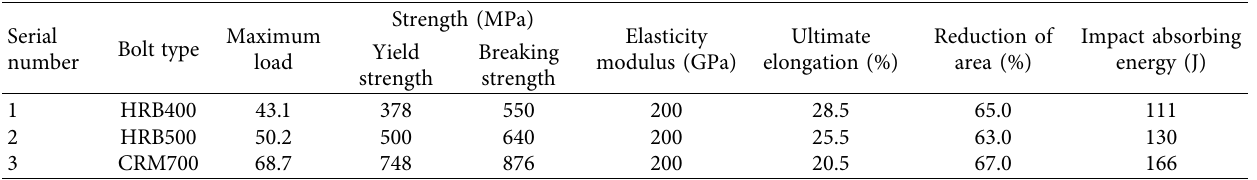
Figure 2: The size of the rock sample and bolt. Table 1: Test results of bolt materials.